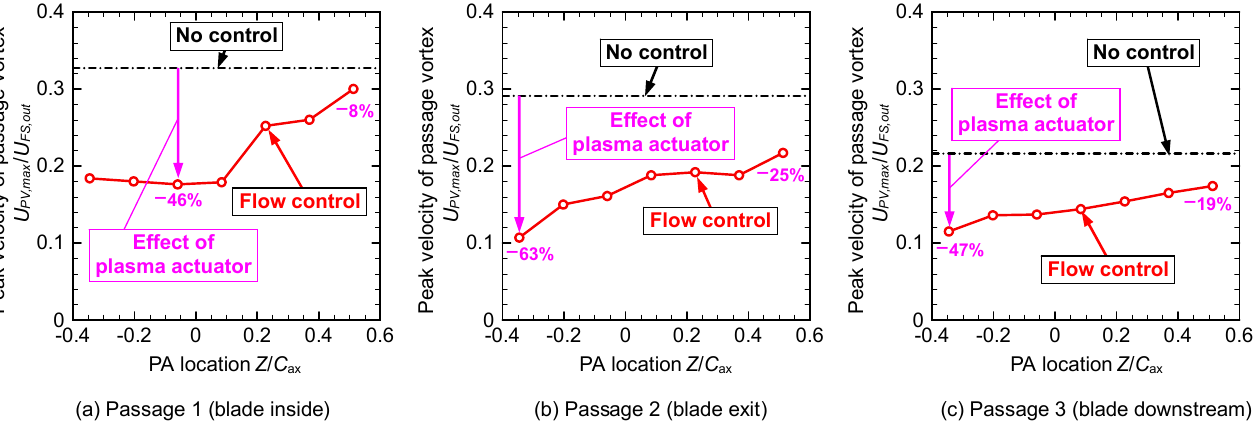
Figure 8. Effect of the plasma actuator location on peak secondary velocity of passage vortex (Re out = 1.8 × 10 4 ).